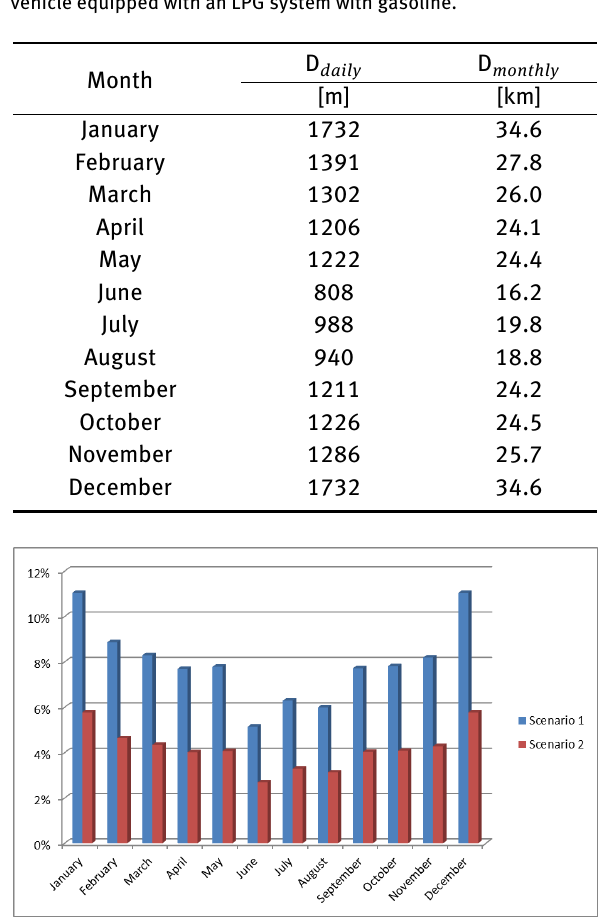
Table 6: Daily and monthly mileage [km] obtained when fueling a vehicle equipped with an LPG system with gasoline.